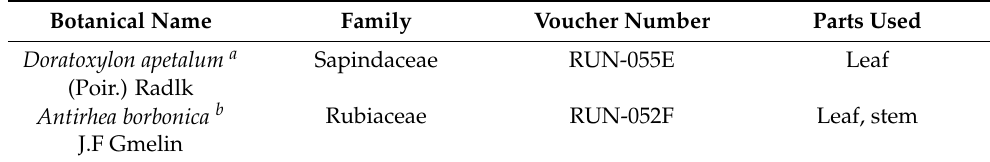
Table 1. Global description of medicinal plants tested. Botanical Name Family Voucher Number Parts Used Doratoxylon apetalum a Sapindaceae RUN-055E Leaf (Poir.) Radlk Antirhea borbonica b Rubiaceae RUN-052F Leaf, stem J.F